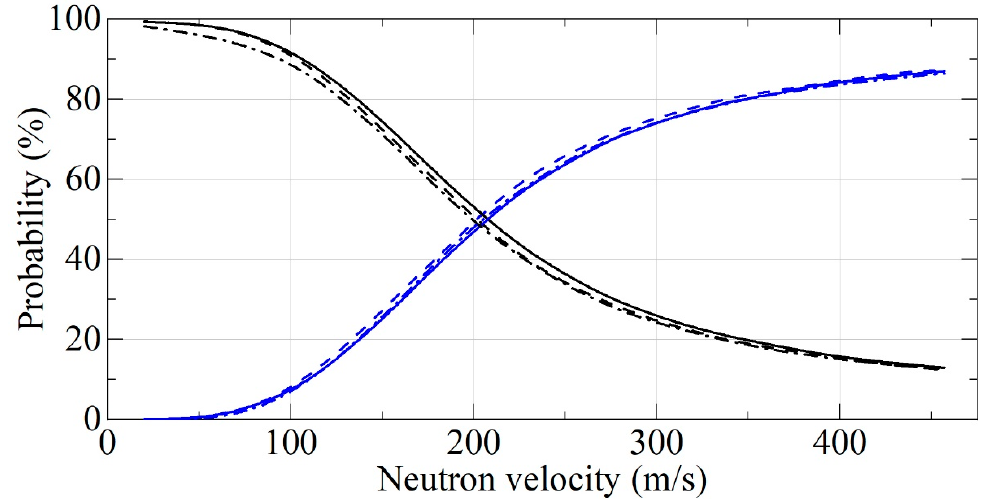
Figure 11. The probability of neutron reflection (black lines) and transmission (blue lines) for F-DNDs (dashed lines) and DF-DNDs (solid lines) and DNDs (dash-dotted lines) versus neutron velocity. The probability of neutron absorption is below 1% for F-DNDs and DF-DNDs at any velocity and 1–5% for DNDs. The incident neutrons are isotropic, the powder density is 0.19 g/cm 3 , and the powder layer thickness is 3 cm.